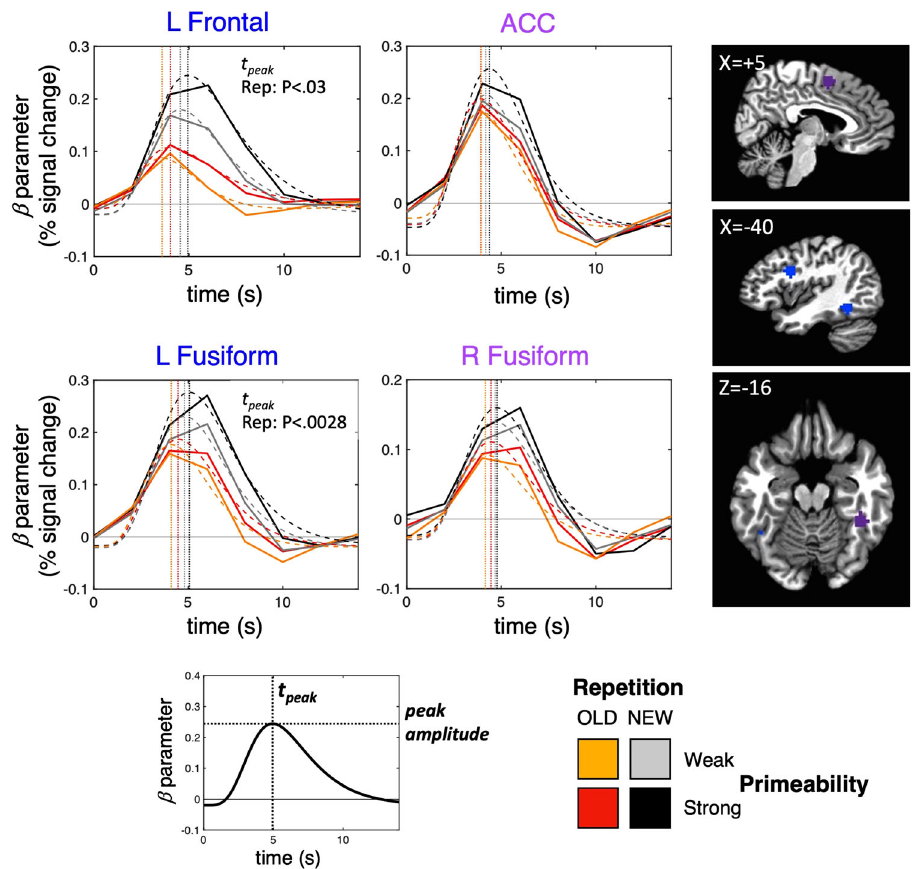
Fig. 9 Assessing activity timing predictions of the Facilitation and Predictive Coding models. A hemodynamic response function model (gamma variate) was fi t to the beta coef fi cients at each timepoint (TR) for each participant and experimental condition, permitting estimates of the peak time ( t peak ) (see graphic at the bottom). Group-average response functions are shown with dashed lines for each condition, and group-average estimates of peak times are shown with vertical dotted lines (mean data on the actual measured beta coef fi cients are shown with solid lines). Main effects of Repetition on peak time were observed in the Left Fusiform and Left Frontal ROIs (OLD peaks earlier than NEW peaks), but there were no signi fi cant interactions between Repetition and Primeability on peak time. Statistics are based on N = 60 independent participants, organized into a factorial design with Task (Overt, Covert Naming) as a between-participant variable. A color key for the experimental conditions is shown at the bottom right (OLD, Strong Primeable = red; OLD, Weak Primeable = orange; NEW, Strong Primeable = gray; NEW, Weak Primeable =